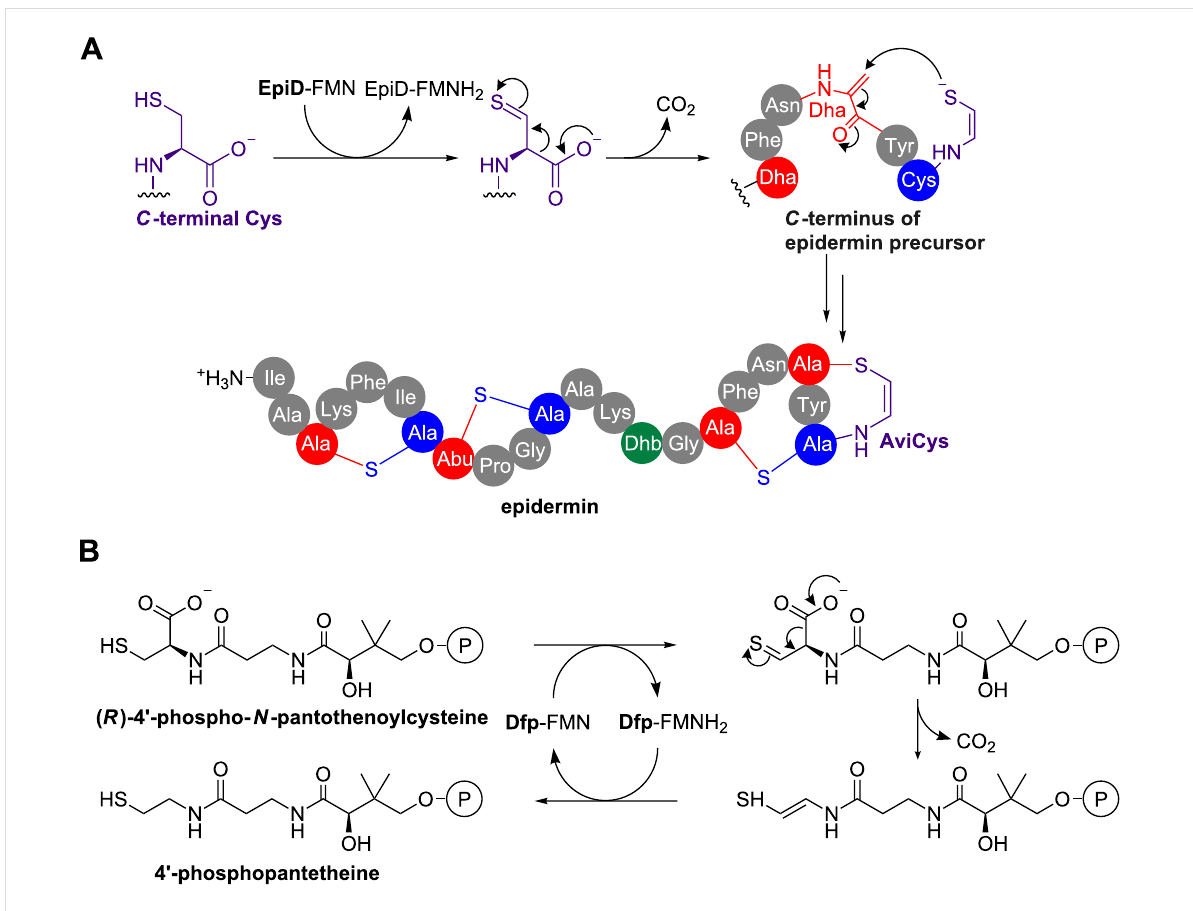
Figure 5: S -[( Z )-2-Aminovinyl]-D-cysteine (AviCys) formation in the epidermin pathway. A) Mechanisms for decarboxylation and 1,4-addition. B) Mechanism for the E. coli Dfp-catalysed conversion of ( R )-4'-phospho- N -pantothenoylcysteine into 4'-phosphopantetheine during coenzyme A bio- synthesis. The function of Dfp was discovered following the mechanistic characterisation of